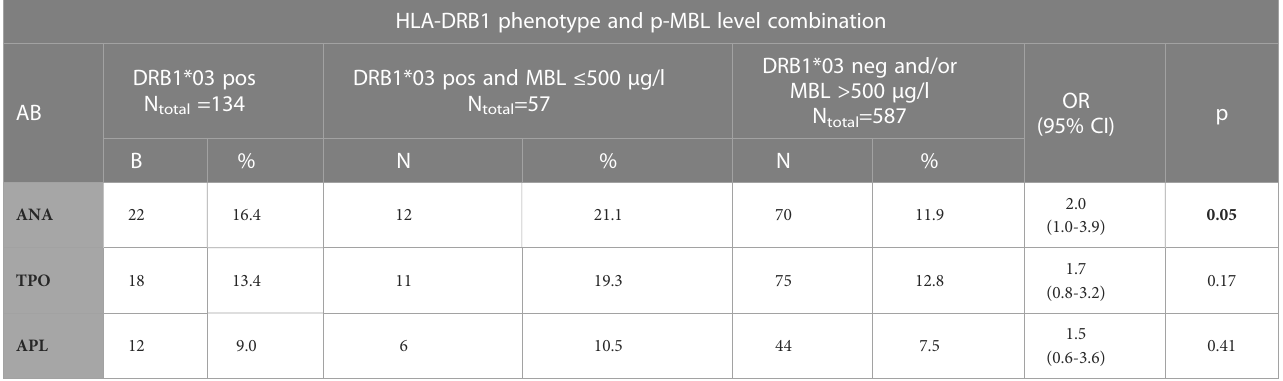
TABLE 5 The frequency of each of the three autoantibody classes in patients with or without the HLA-DRB1*03/low plasma MBL combination. HLA-DRB1 phenotype and p-MBL level